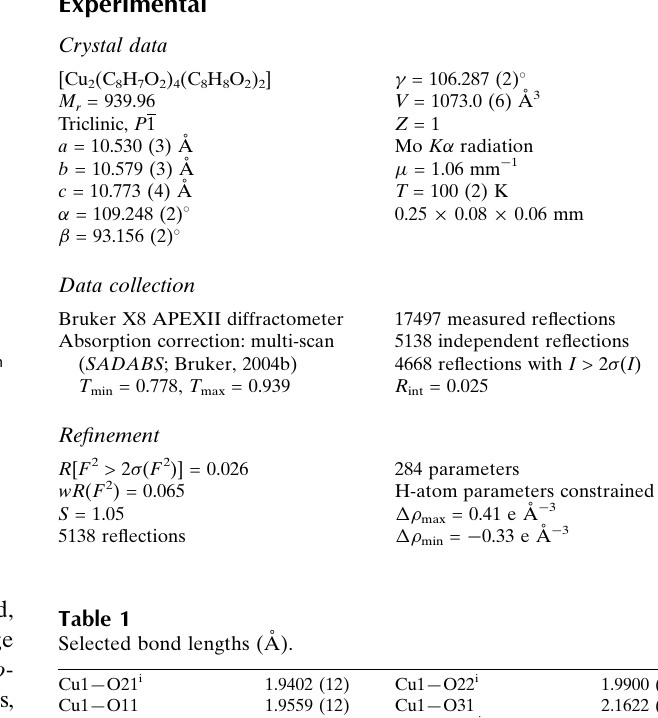
Selected bond lengths (A˚ ).